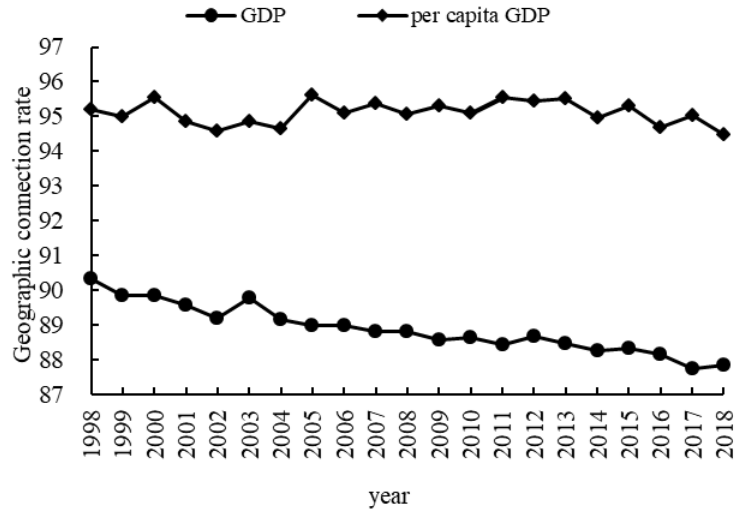
Figure 5. Change in the geographical connection rate between CLP index, GDP and per capita GDP.